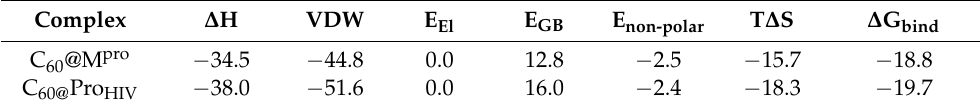
Table 1. Energy components of ΔG binding (VDW, E el , E GB , and E non-polar ) for C 60 @M pro and C 60 @Pro HIV complexes. All energies are reported in kcal mol −1 .